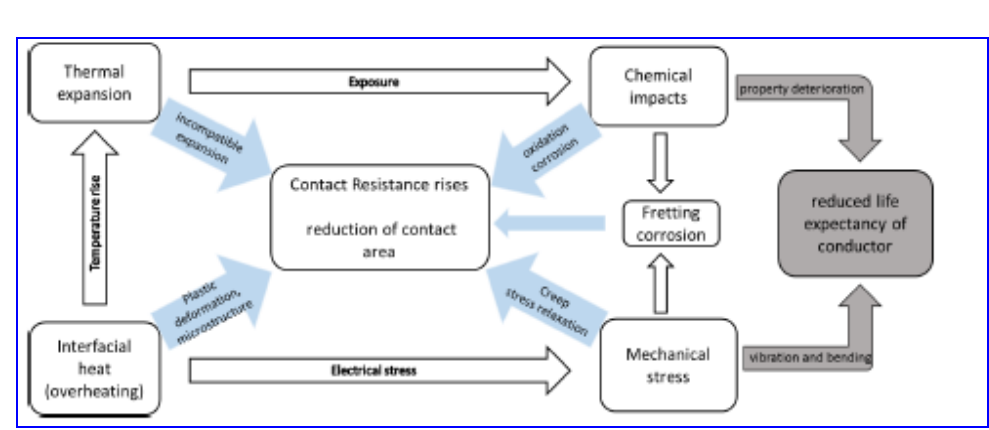
Figure 2: Schematic of degradation mechanisms in an aluminium connector